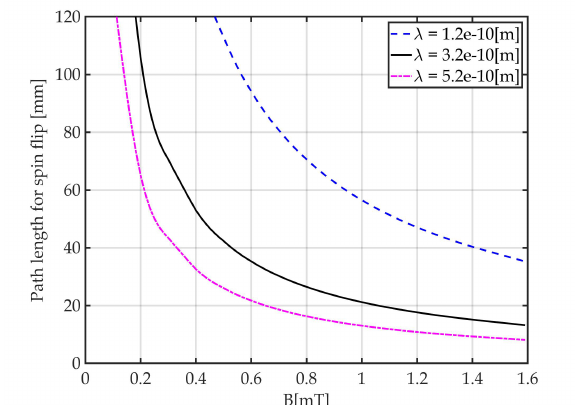
Figure 2. Dependence of path length for a spin flip as a function of magnetic field strength for three different wavelengths. If a neutron moves slower through B (large λ ), the larger will be the spin rotation angle φ and therefore the shorter is the path for a